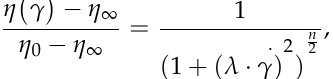
Figure 2. Experimental (measured) viscosity flow curves fitted to Ostwald or power-law model ( a ) and Carreau model ( b ).